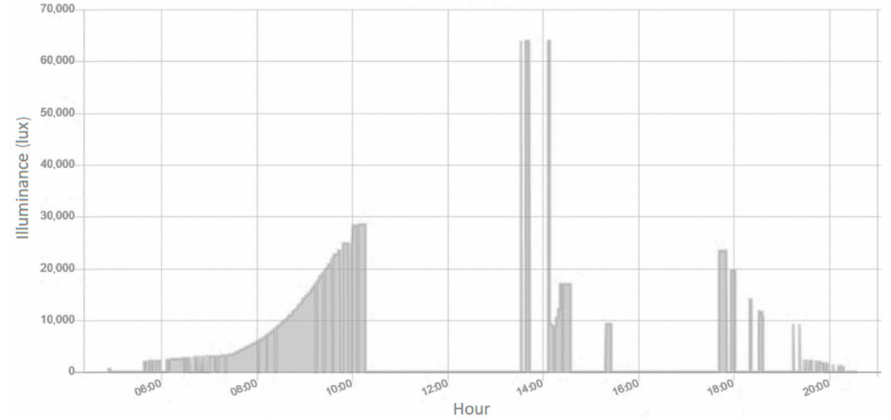
Figure 14. Illuminance graph (panel 3) of 3 June 2019.